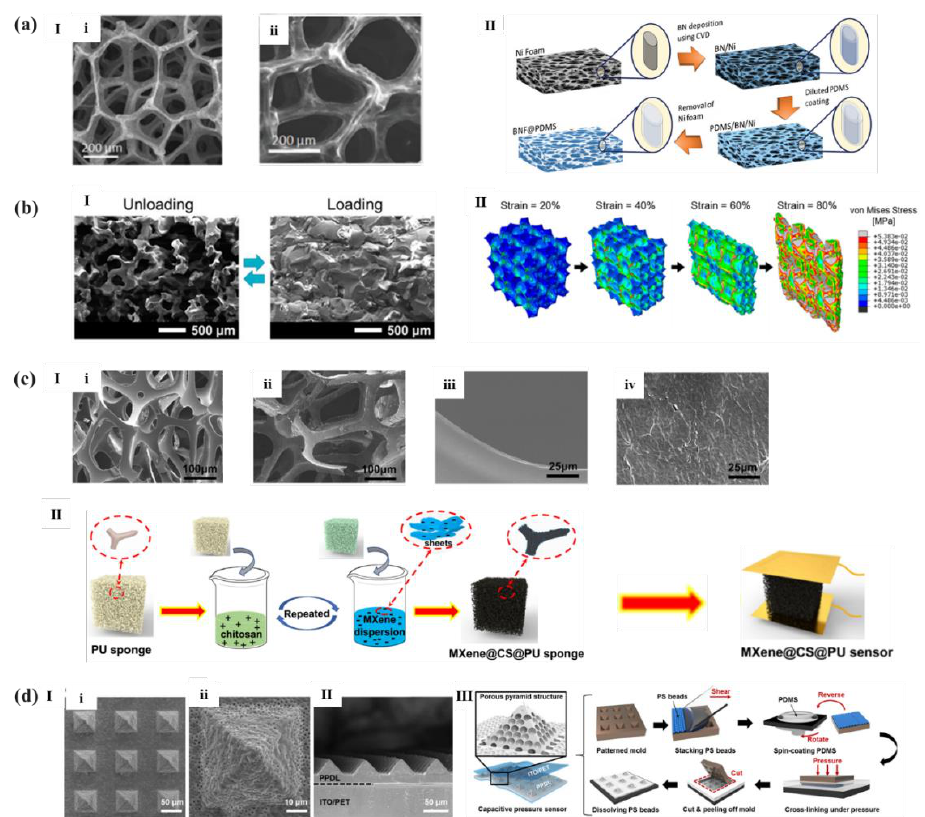
Figure 13. ( a ): ( I ) SEM image of a free-standing BNF ( i ) and its corresponding EDX elemental mappings of the BNF/PDMS ( ii ); ( II ) Schematic of the fabrication process of BNF/PDMS [107]. ( b , I ) SEM images of the porous Ecoflex dielectric layer before and after being compressed; ( II ) Gradual compressive behavior of the representative model of the porous Ecoflex dielectric cube [108]. ( c , I ) SEM images of the backbones of neat PU sponge ( i , iii ) and of MXene/CS/PU sponge ( ii , iv ); ( II ) Schematic illustrating the fabrication process of MXene/CS/PU sponge sensor [109]. ( d , I ) The top view of SEM images of the PPDL; ( II ) The cross-sectional view of SEM images of the PPDL; ( III ) Schematic depiction of PPDL fabrication process [110].